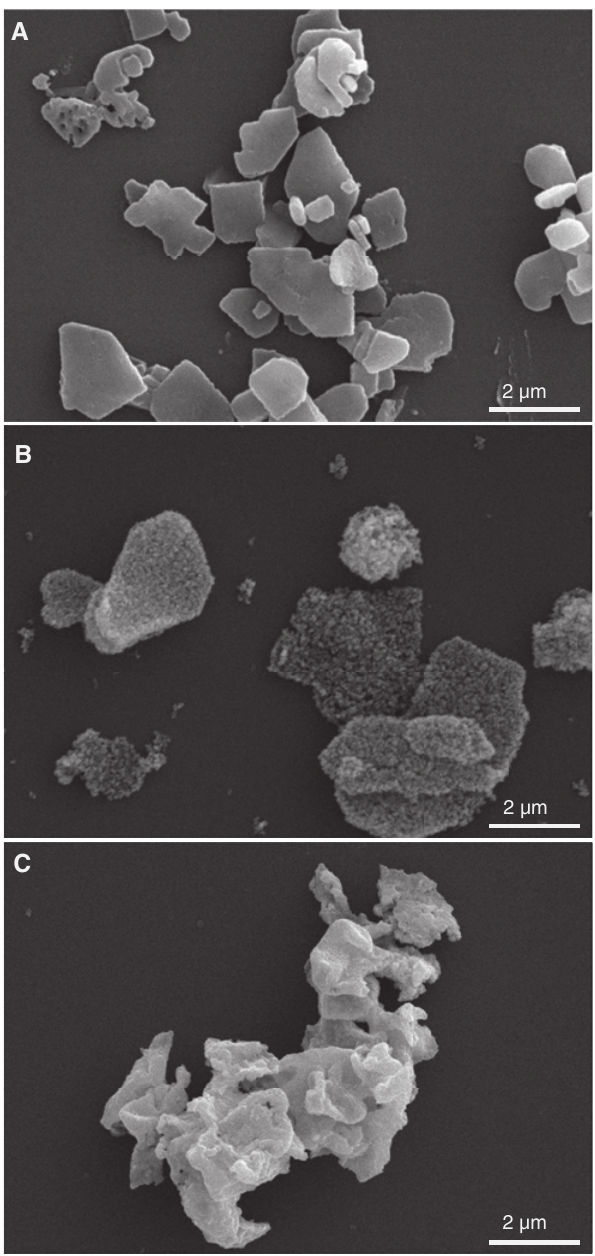
) RuCl powder and 4 2 6